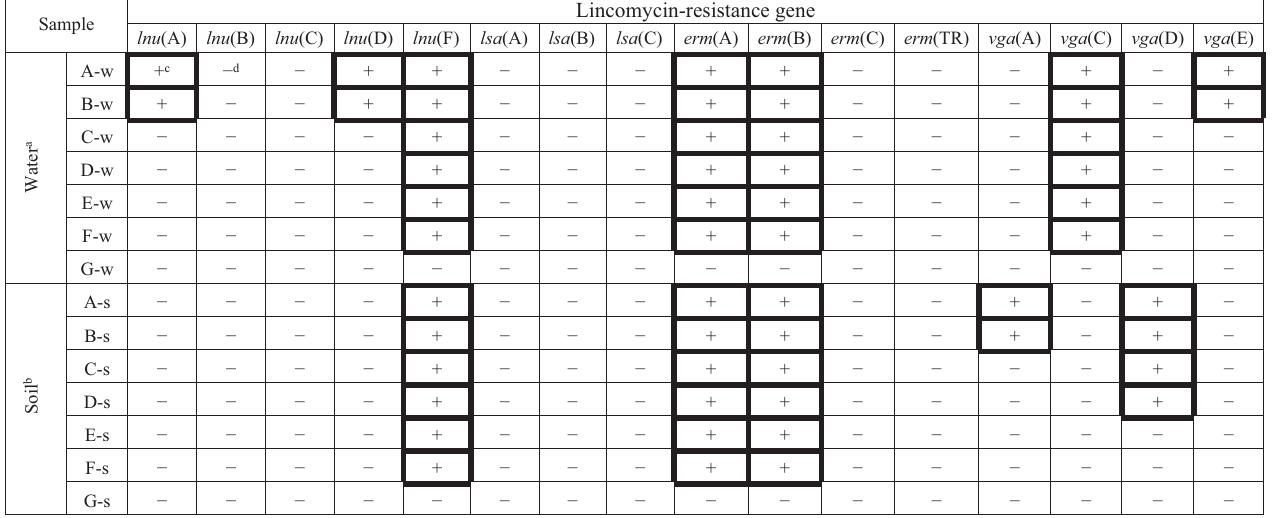
Lincomycin-resistance gene